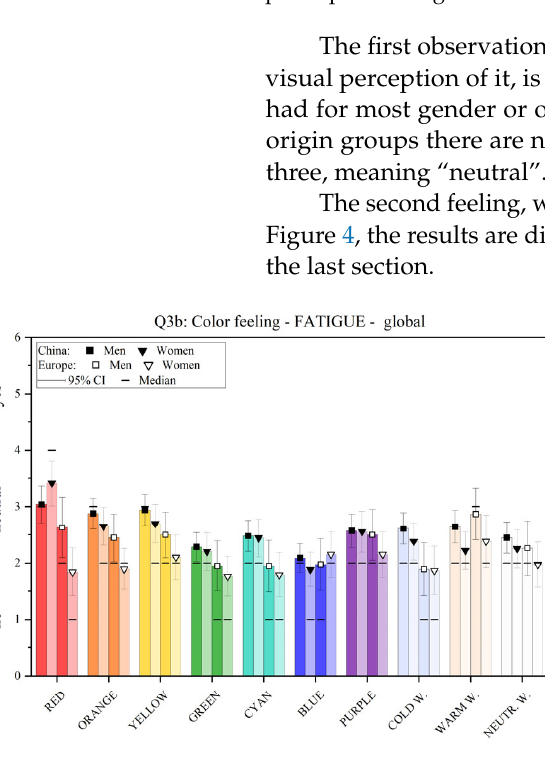
Figure 3. ( a ) Color ‐ joy rating and ( b ) statistical evaluation separated between Chinese and European participants and genders. Statistical significances p < 0.05 marked with *.